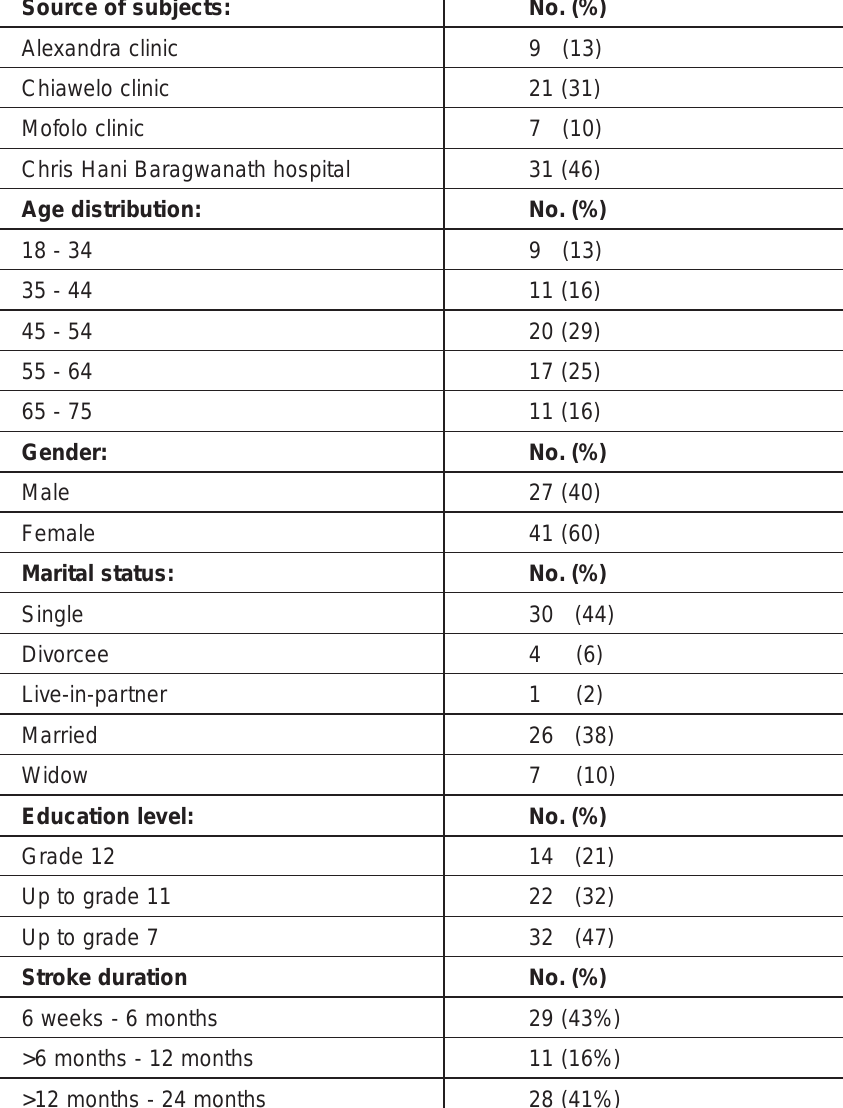
Table 1: Demographic results (n =